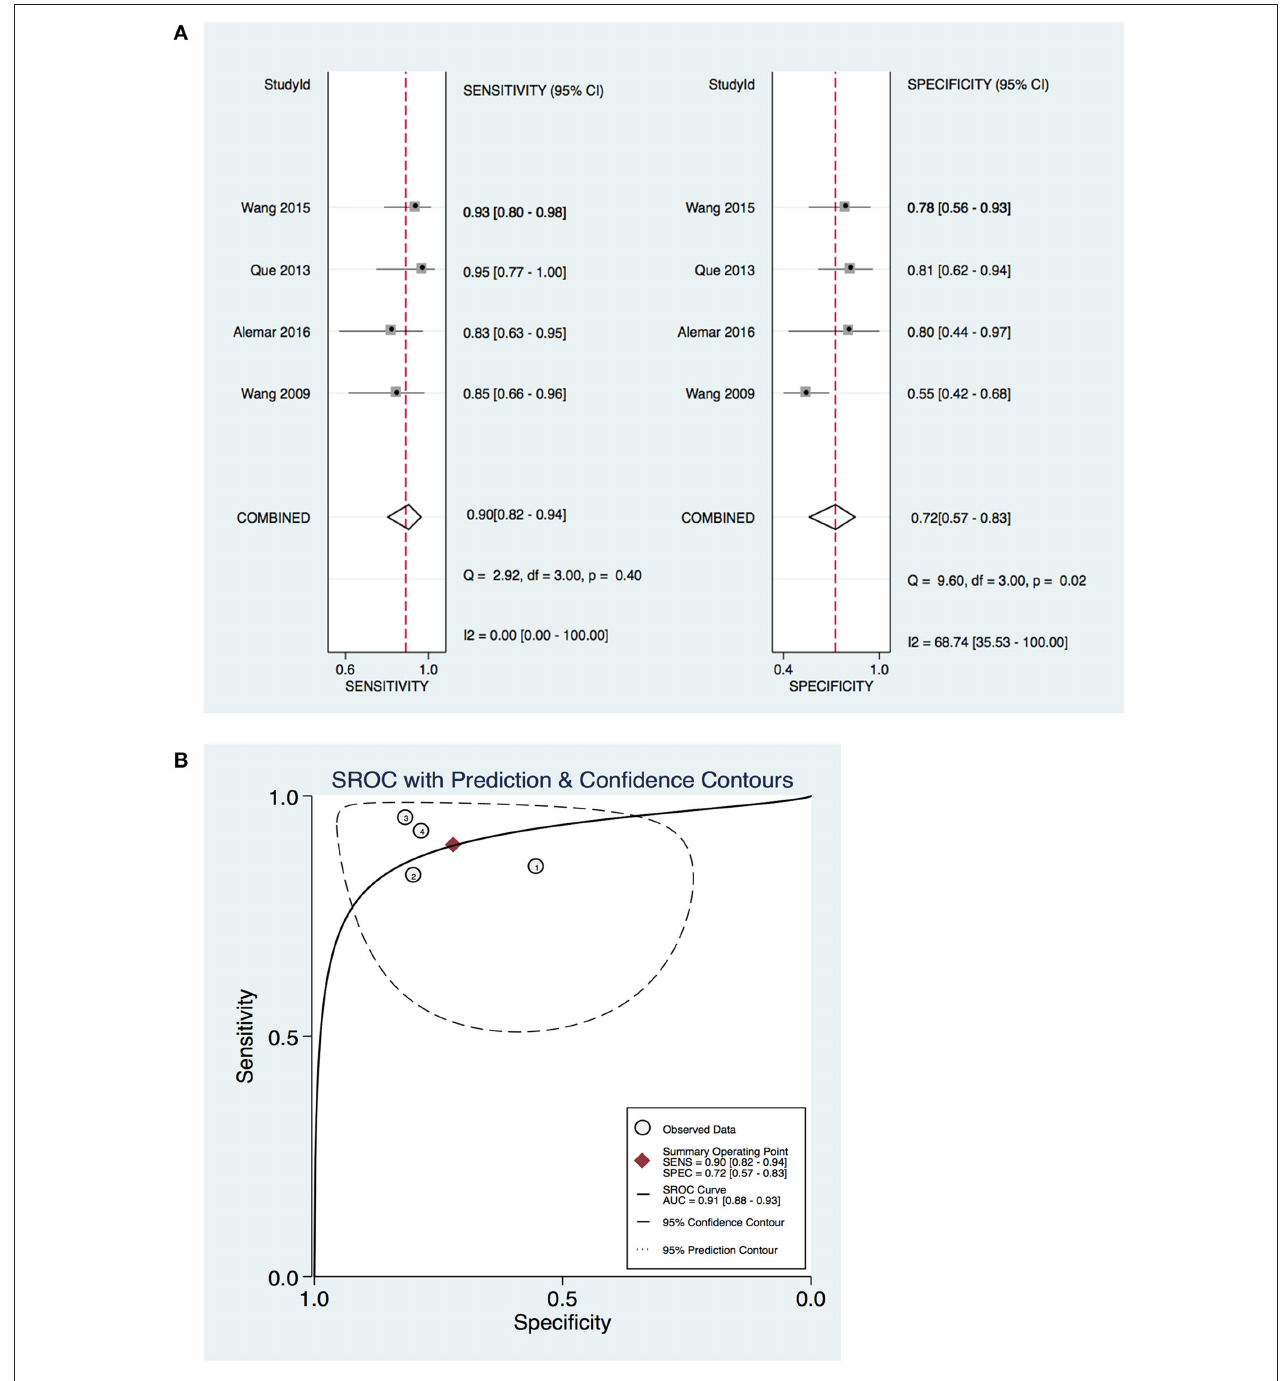
FIGURE 7 | Diagnostic value of miR-21 on pancreatic cancer. (A) Forrest plot of estimates of sensitivity and specificity (B) Summary receiver operating characteristic (SROC) curve.